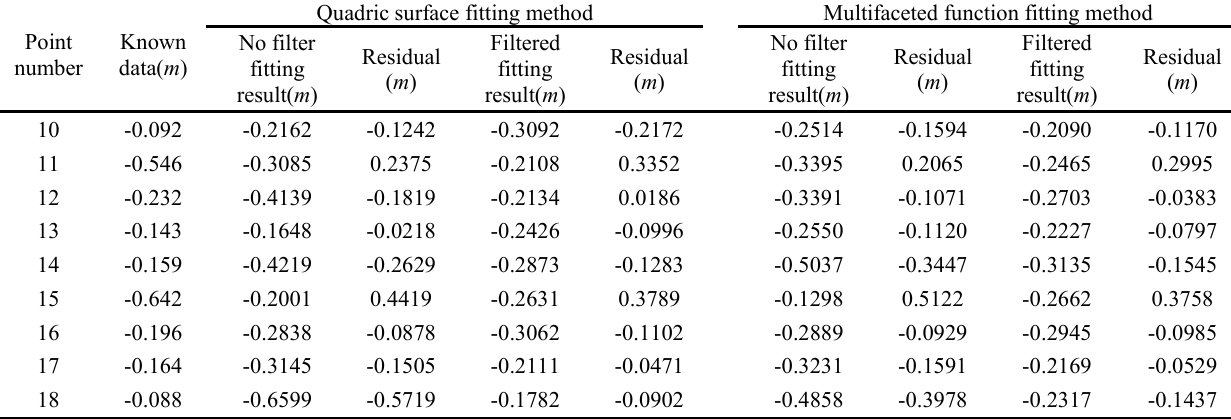
Table 1. Using Vondrak filter to improve the previous fitting method and improved fitting residual comparison results It can be seen from Table 1. that whether it is a quadric surface fitting or a multi-faceted function fitting, the residual difference obtained by adding Vondrank filtering is much smaller than the residual value improved without filtering, and the overall fitting is the residual is more stable.